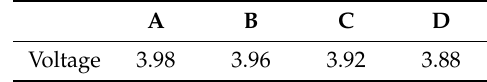
Table 1. The initial cell voltages of four batteries (voltage unit: V).